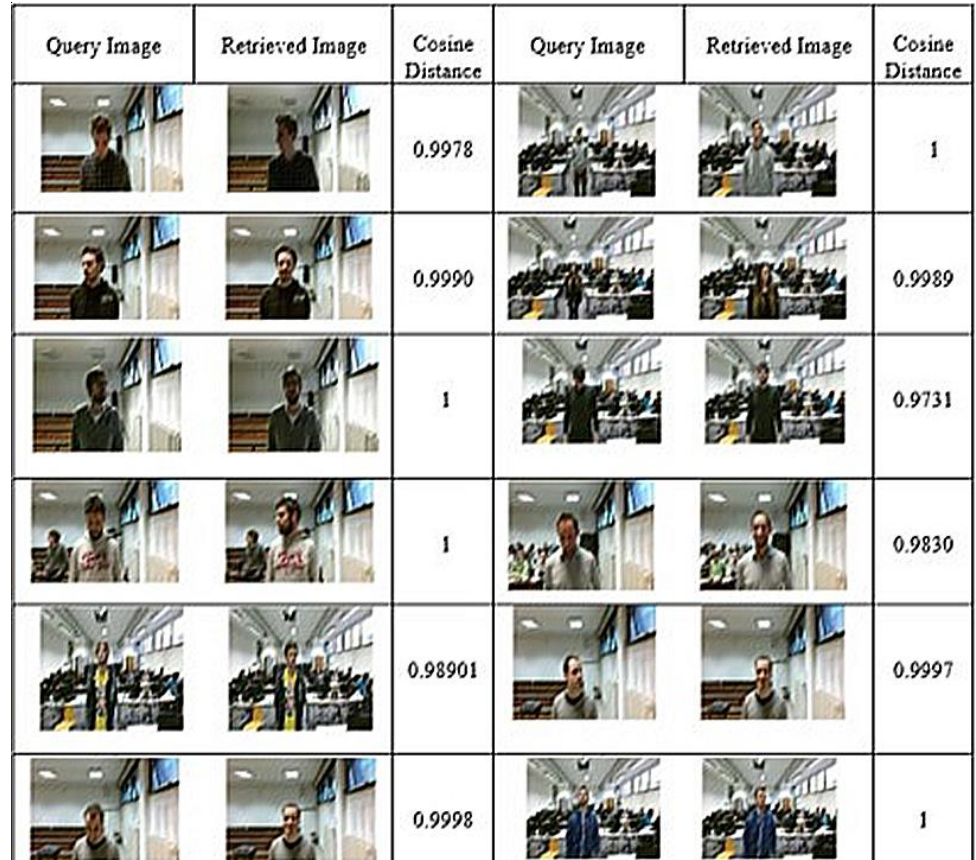
Figure 13. Results on WANG 1000 images.